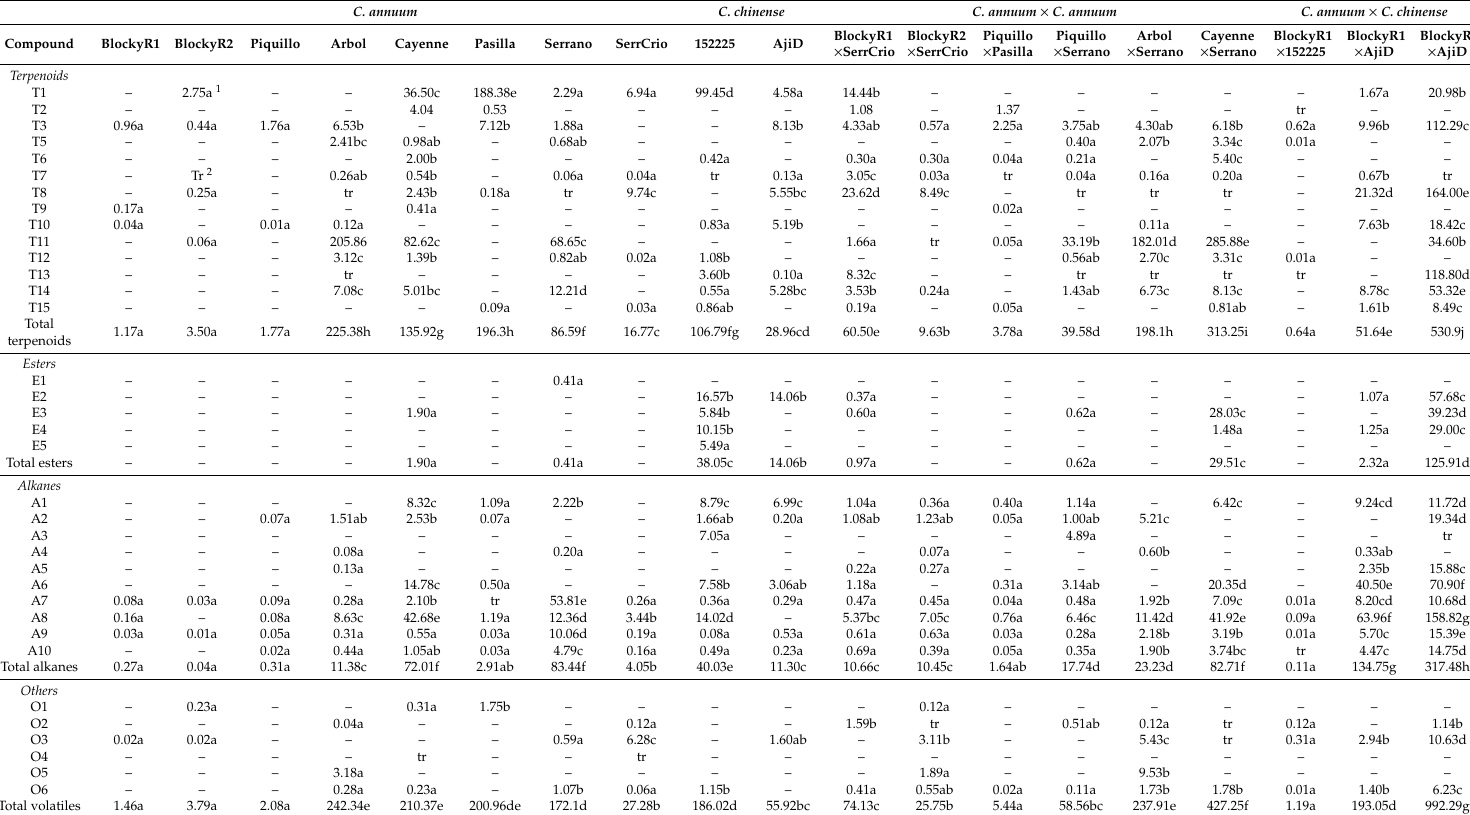
Table 3. Individual compounds with average gas chromatography (GC) peak area units ( × 10 6 ) identified in the fruit pericarp of Capsicum accessions and hybrids